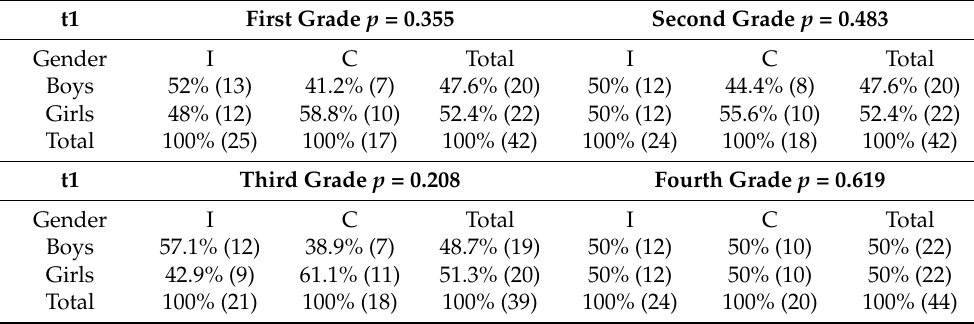
Table 1. Sample distribution according to gender and grade in t1.